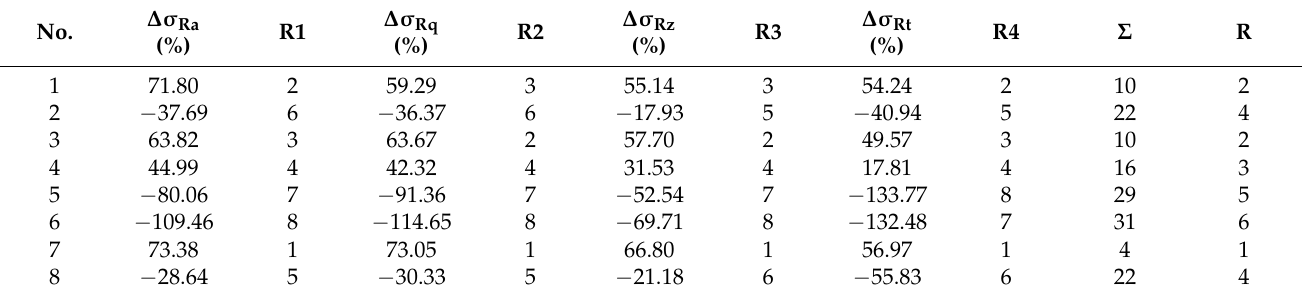
Table 8. Ranking of results for Experiment I.